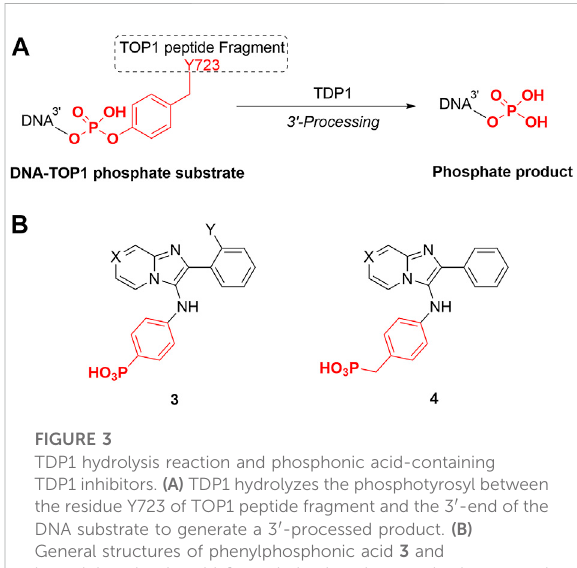
FIGURE 3 TDP1 hydrolysis reaction and phosphonic acid-containing TDP1 inhibitors. (A) TDP1 hydrolyzes the phosphotyrosyl between the residue Y723 of TOP1 peptide fragment and the 3 ′ -end of the DNA substrate to generate a 3 ′ -processed product. (B) General structures of phenylphosphonic acid 3